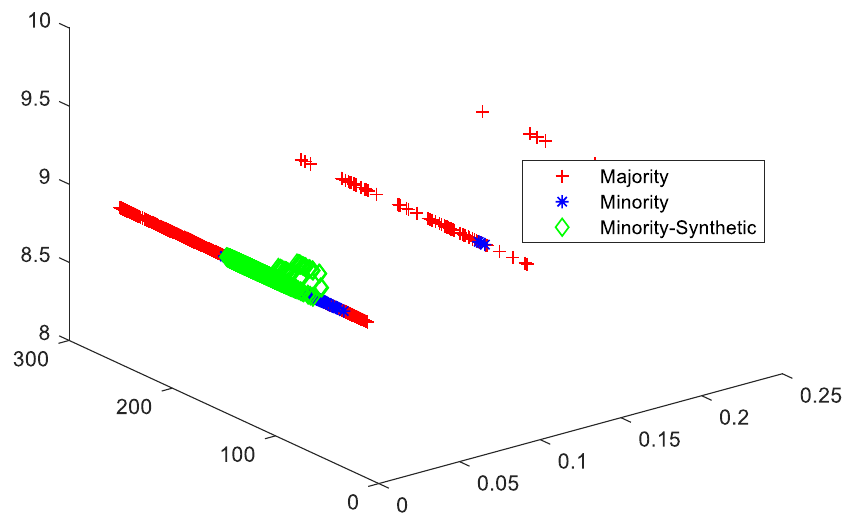
Figure 6. Cluster view of data distribution in cluster among majority and minority for the proposed SMOTE-PSOEV for Segment0 dataset.